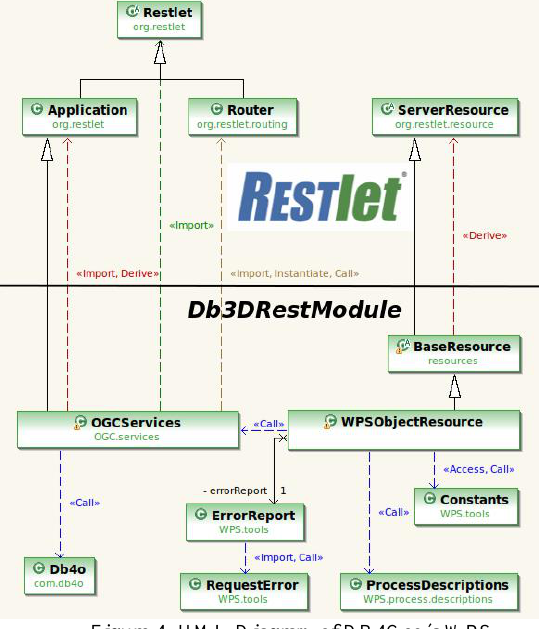
Figure 4: UML-Diagram of DB4Geo´s